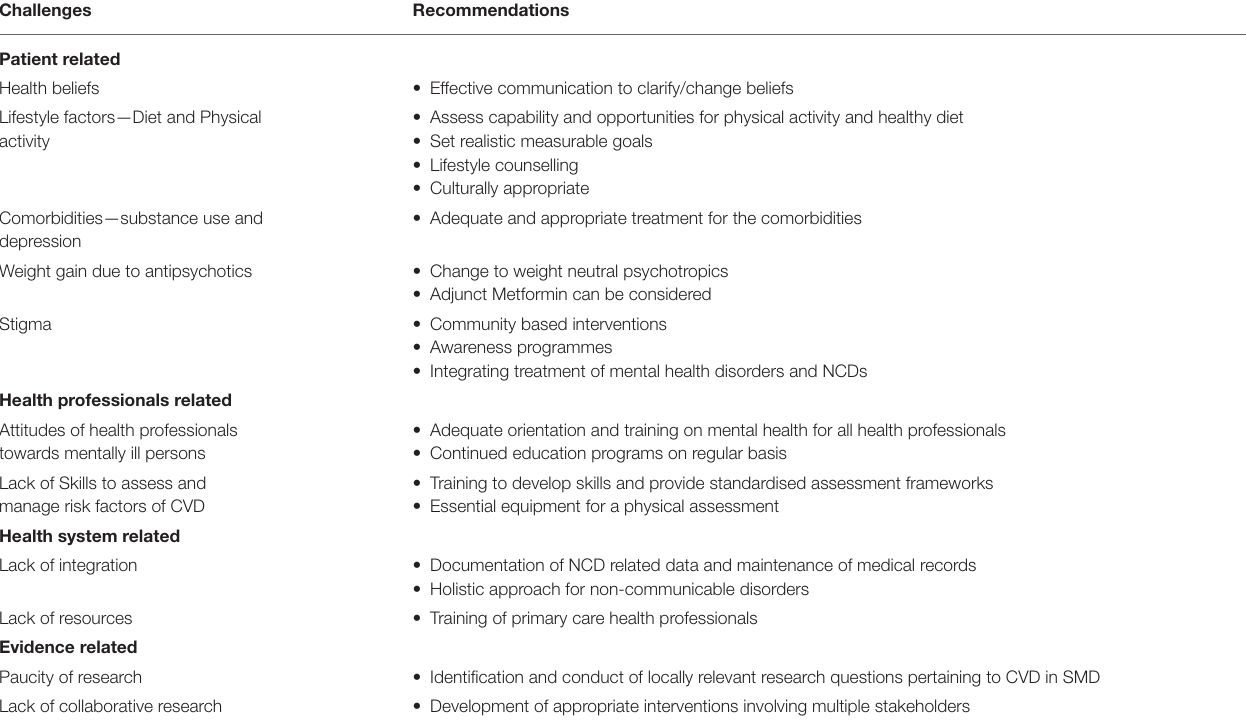
TABLE 2 | Challenges and recommendations to improve cardiovascular health and diseases among persons with